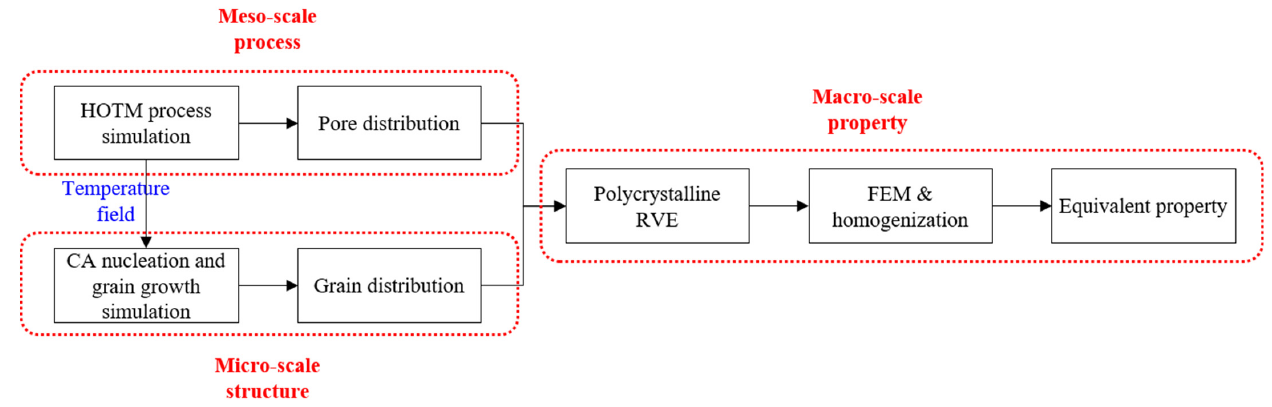
Figure 9. The process–structure–property multi ‐ scale simulation framework.